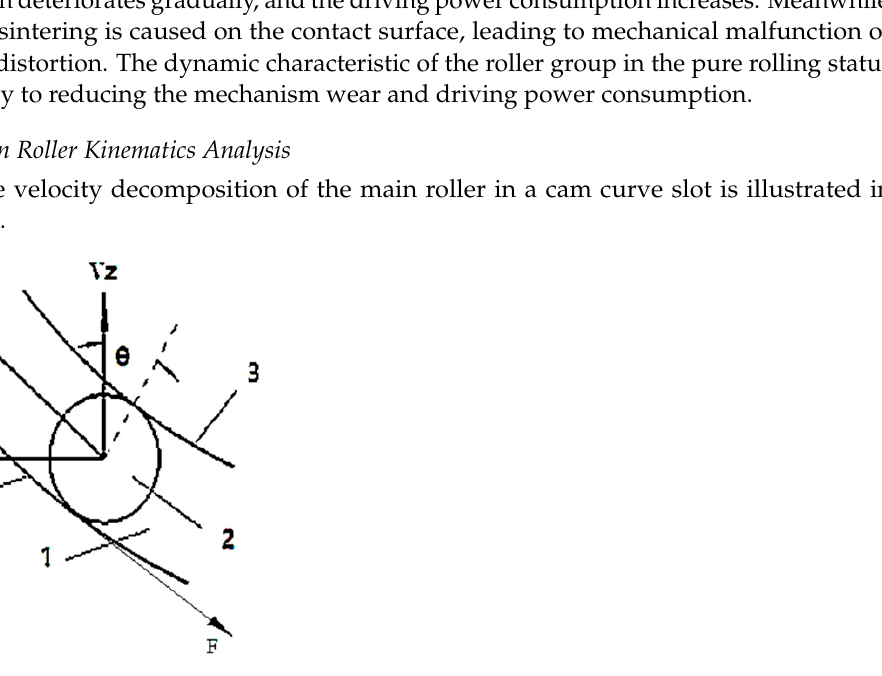
5 of 25 Figure 5. Bolt body model. Note: 1—bolt body, 2—bolt nose, and 3—a missile. As the cycles of the main roller slide along the cam curve slot surface, the friction